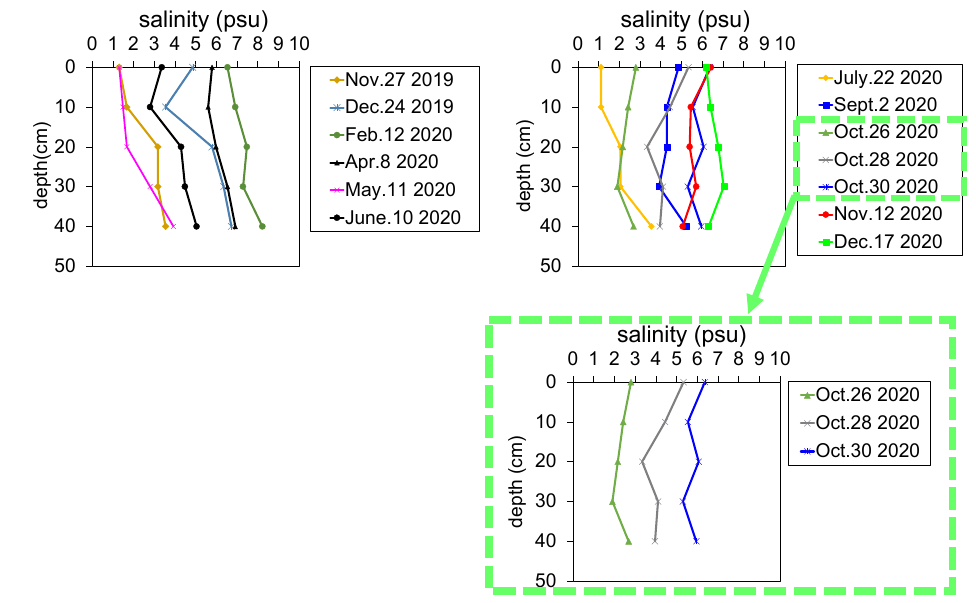
Figure 7. Observation method of soil salinity.